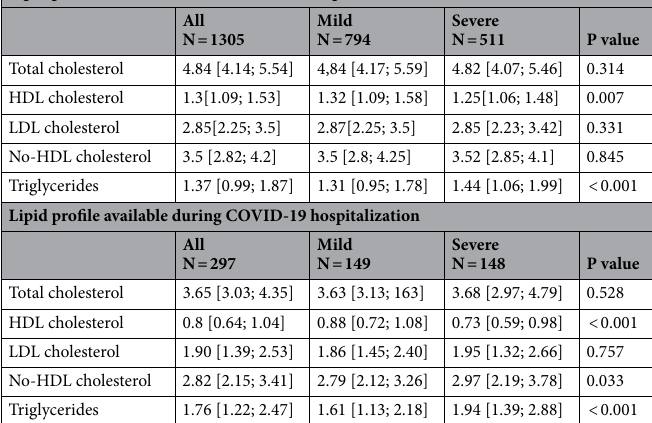
Table 1. Lipid profile of patients with data available before or during COVID-19 infection. *Median [interquartile range]. To convert mmol/L to mg/dl: cholesterol values × 38.6; triglyceride values ×